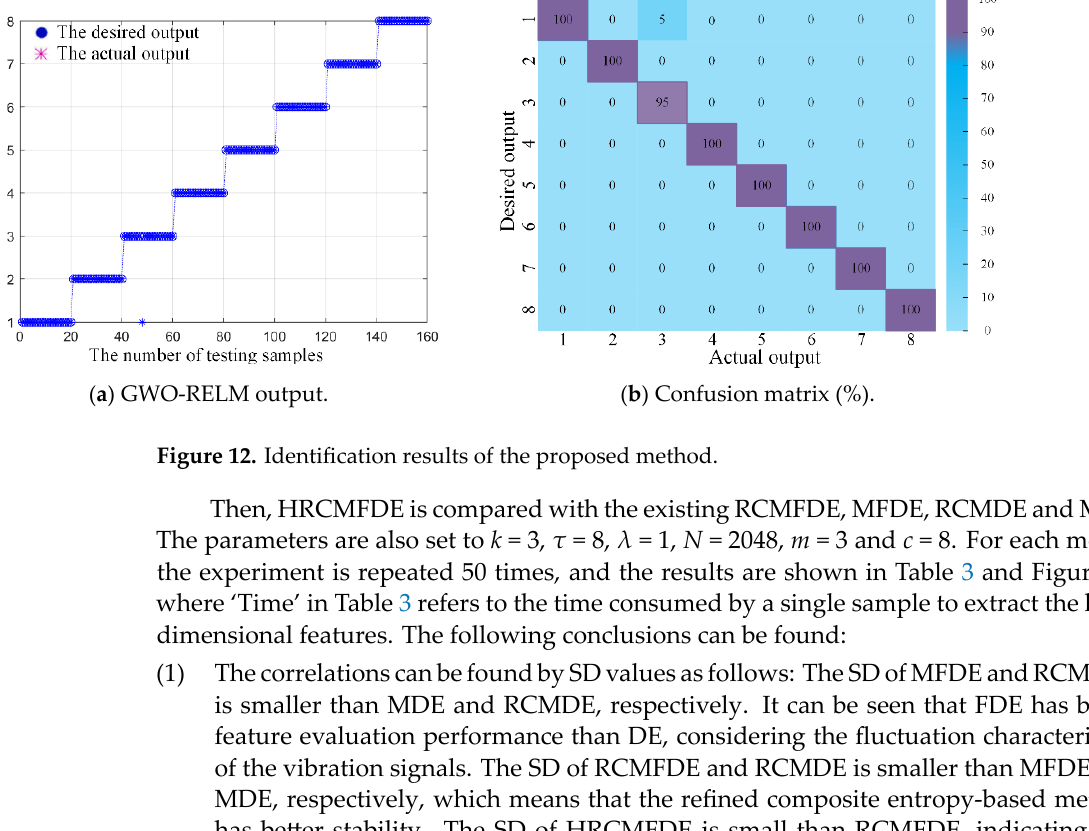
Figure 12. Identification results of the proposed method.